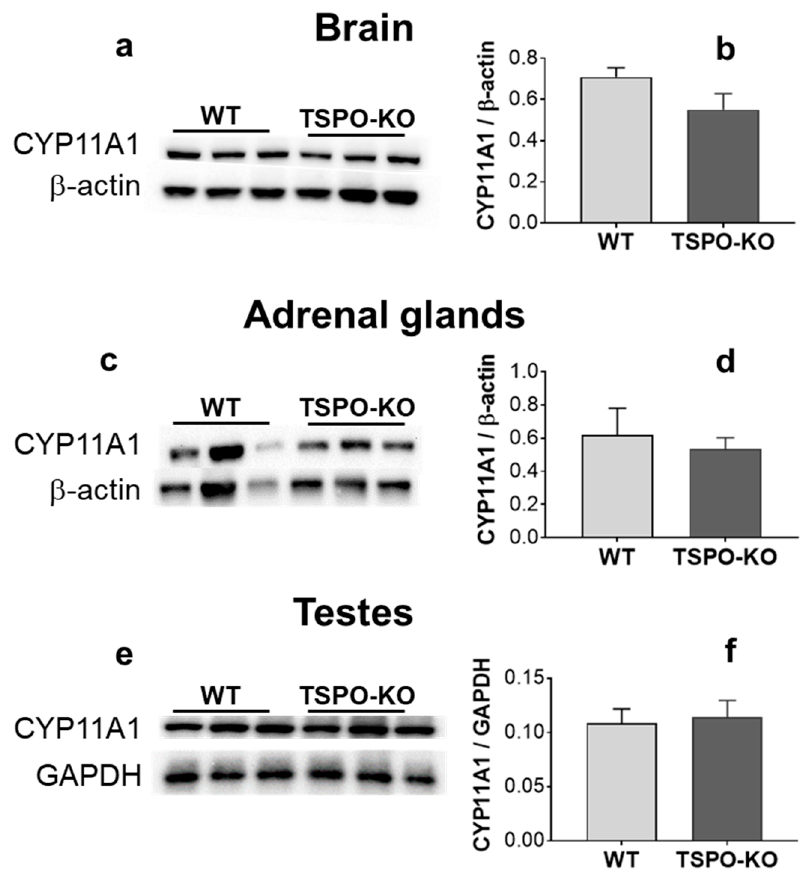
Figure 9. Western blot analysis of CYP11A1 protein levels in the brain, adrenal glands and testes from TSPO-KO and WT mice. Representative bands of VDAC-1 and the loading controls β -actin or GAPDH for all tissues are shown ( a , c , e ). Quantification of CYP11A1 levels was normalized to the loading control ( b , d , f ).